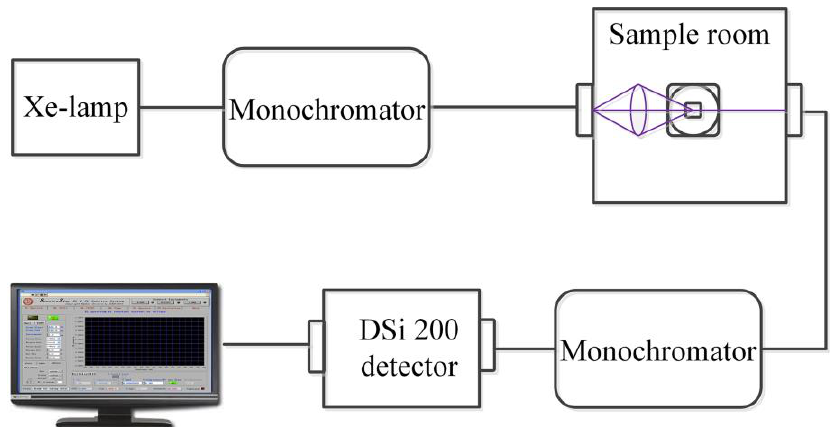
Figure 2. The schematic diagram of the experimental setup for the PL